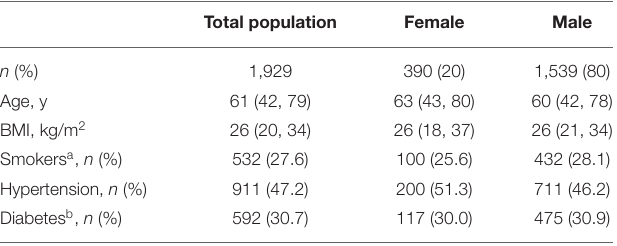
TABLE 2 | Characteristics of the study